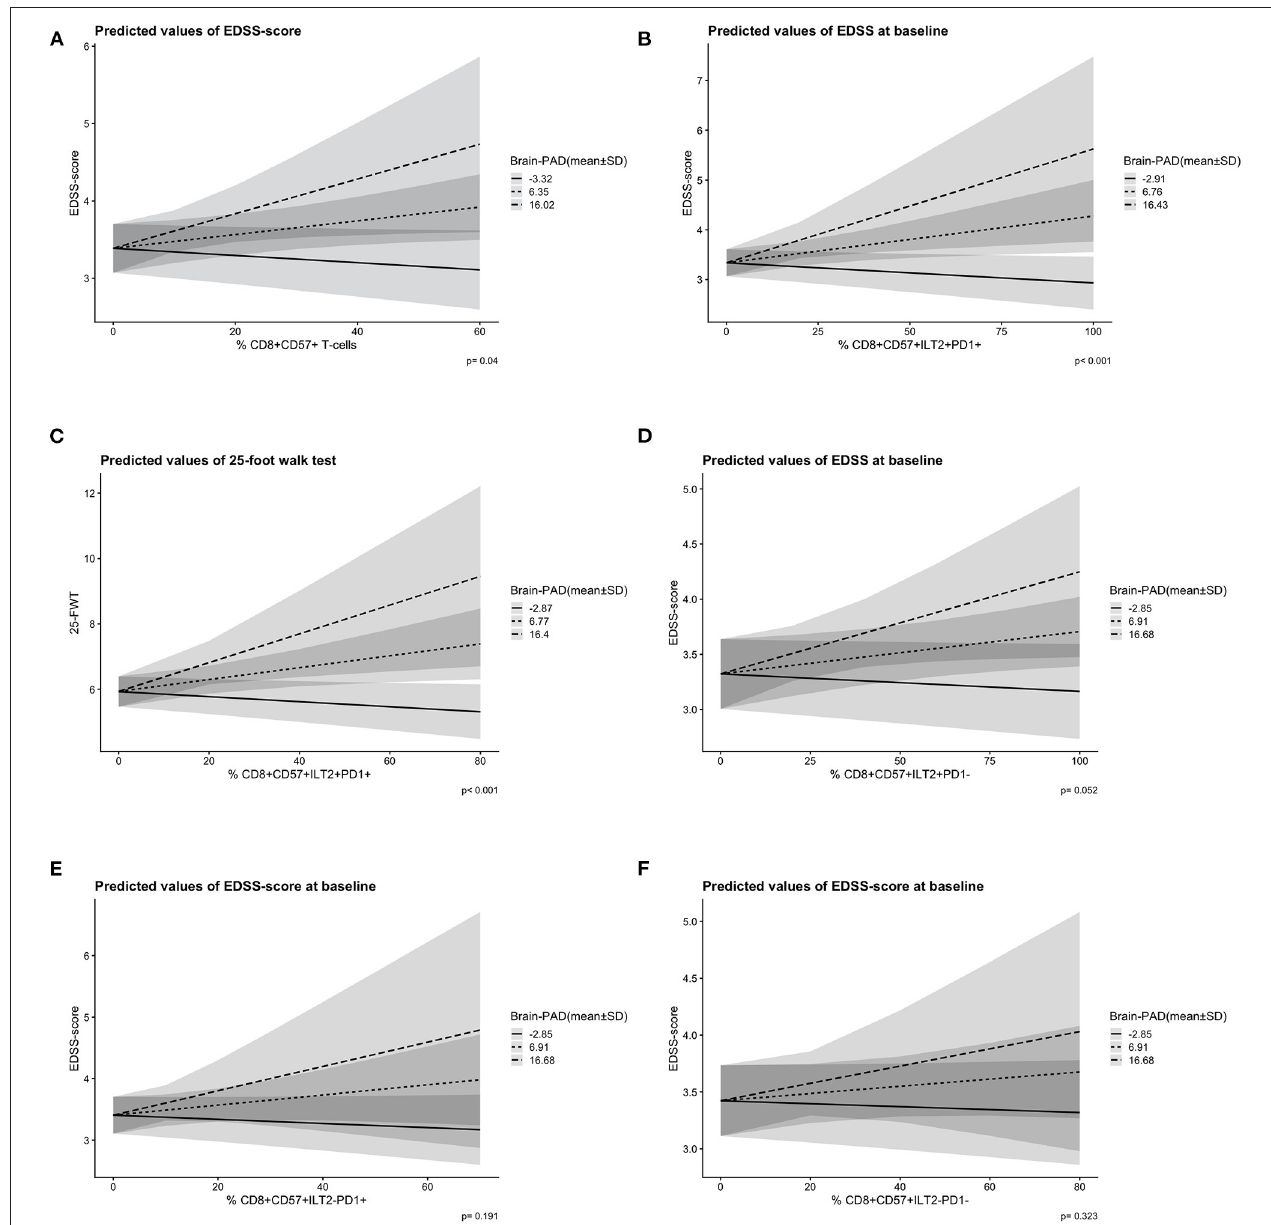
FIGURE 2 | Predicted slopes illustrate the two-way interaction between ILT2/PD-1 positive and negative CD8 + CD57 + T-cells and brain-PAD [mean ± 1 standard deviation (SD)] on disability score. (A) A higher CD8 + CD57 + T-cell frequency (x-axis) and a higher brain-PAD (prediction lines) predicted a higher EDSS-score (y-axis) significantly, p = 0.04. (B) A higher CD8 + CD57 + ILT2 + PD-1 + T-cell frequency (x-axis) and a higher brain-PAD (prediction lines) predicted a higher EDSS-score (y-axis) significantly, p < 0.001. (C) A higher CD8 + CD57 + ILT2 + PD-1 + T-cell frequency (x-axis) and a higher brain-PAD (predicted lines) predicted a higher 25-FWT-score (y-axis) significantly, p < 0.001. (D) A non-significant interaction effect of CD8 + CD57 + ILT2 + PD-1 − T-cells (x-axis) and brain-PAD (prediction lines) on EDSS-score (y-axis), p = 0.052. (E) A non-significant interaction effect of CD8 + CD57 + ILT2 − PD-1 + T-cells (x-axis) and brain-PAD (prediction lines) on EDSS-score (y-axis), p = 0.191. (F) A non-significant interaction effect of CD8 + CD57 + ILT2 − PD-1 − T-cells (x-axis) and brain-PAD (prediction lines) on EDSS-score (y-axis), p = 0.323. PD-1, programmed death 1; ILT2, immunoglobulin-like transcript 2; EDSS, expanded disability scale status; 25-FWT, 25-food walk test; brainPAD, brain predicted age difference (brain-PAD). Brain-PAD is divided in three subgroups based on the mean value of brain-PAD ± 1SD represented by a striped line (mean brain-PAD − 1SD); a dotted line (mean brain-PAD); and a continuous line (mean brain-PAD + 1 SD). The shaded areas represent the 95% confidence intervals.